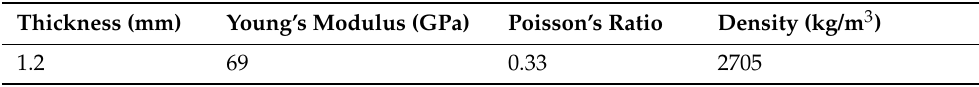
Figure 2. Panel ( a ): Schematic view of the aluminium joint. ( b ): detailed geometry of the joint, including its braces. Table 1. Mechanical properties of aluminium